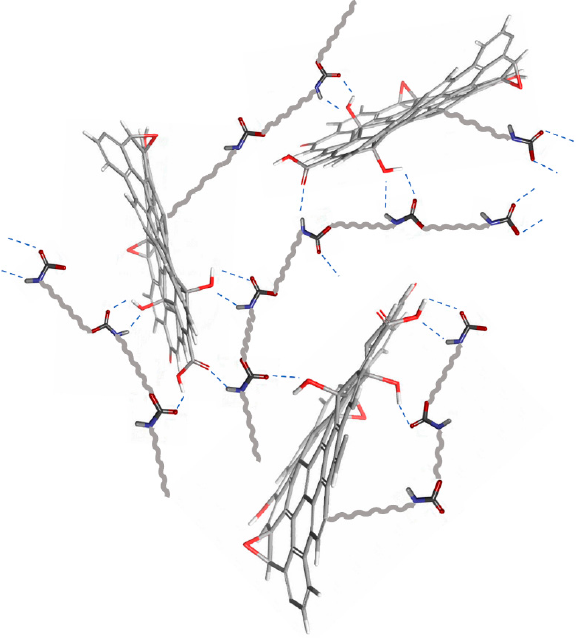
Figure 4. Schematic representation of possible interaction of reduced GON with PU under UV irradi- ation.